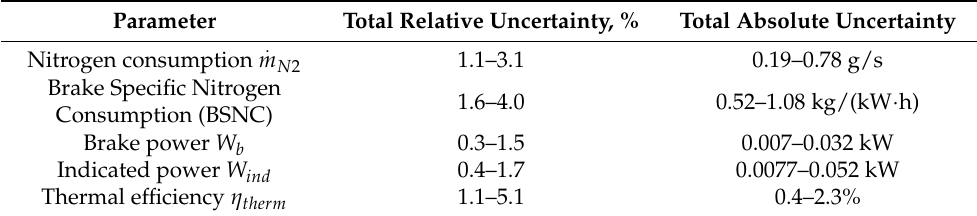
Table 2. Uncertainties in calculations of engine